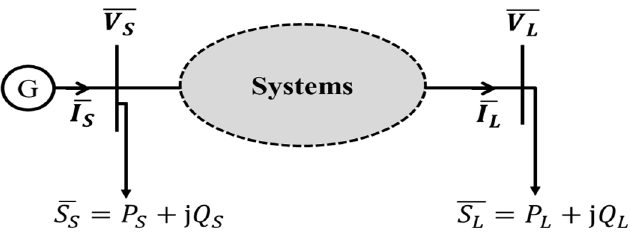
Figure 2. Configuration of virtual single bus systems.